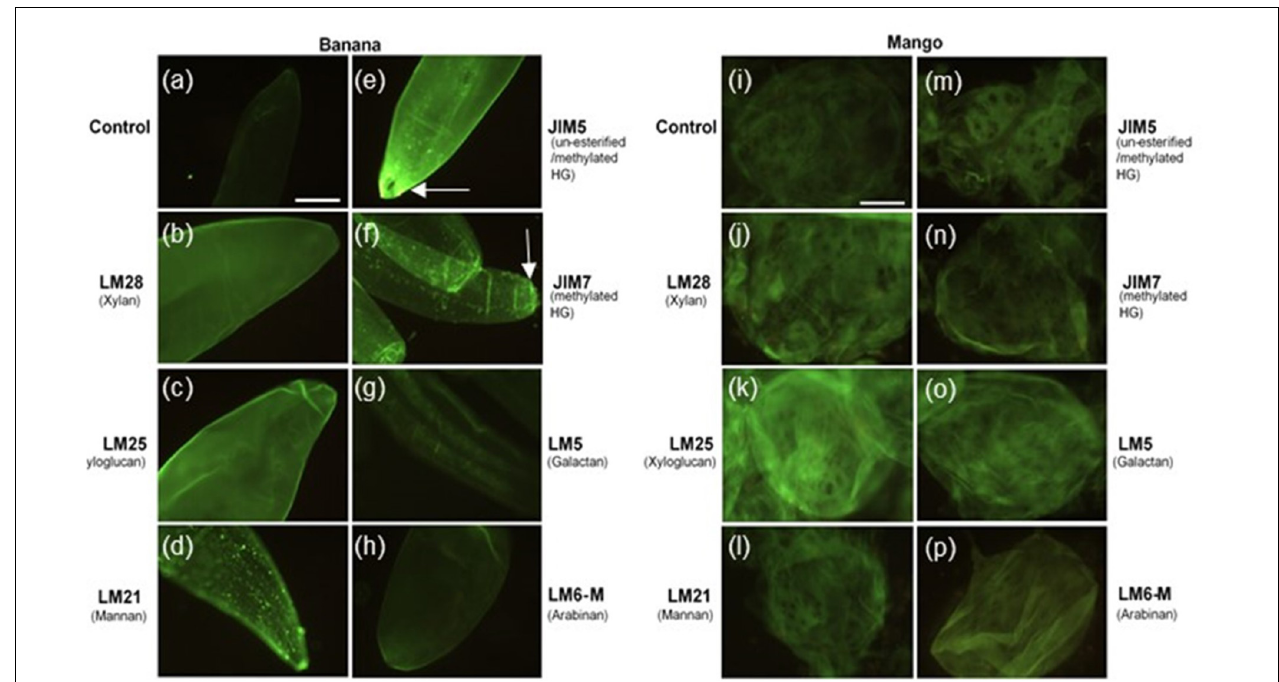
FIGURE 2 | Banana (a–h) and mango (i–p) cells labeled with LM28, LM25, LM21, JIM5, JIM7, LM5 and LM6-M antibodies observed under fluorescence microscope equipped with blue epifluorescence. Scale bar = 50 µ m. Arrows point to labeling at the tips of banana cells.